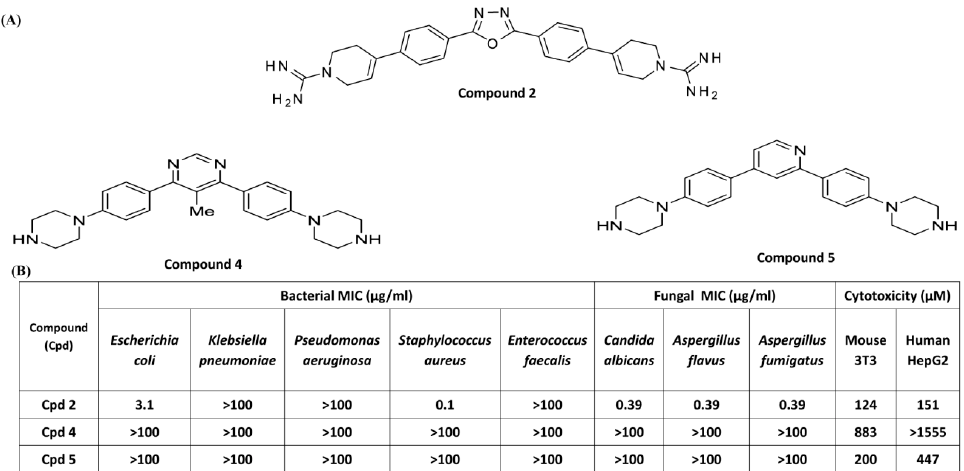
Figure 4. Structure and antibacterial activity of three smHDPMs compounds. ( A ) Structure of compound (Cpd) 2 and two of its derivatives, Cpd 4 and Cpd 5. ( B ) Minimum inhibitory concentration (MIC) values ( µ g / mL) of smHDPMs against three Gram-negative bacteria ( Escherichia coli, Pseudomonas aeruginosa, Klebsiella pneumonia ) and two Gram-positive bacteria ( Staphylococcus aureus and Enterococcus faecalis ). Cytotoxicity of smHDPMs on 3T3 and HepG2 cell lines. CC 50 concentration of drug that reduces 50% cell growth.